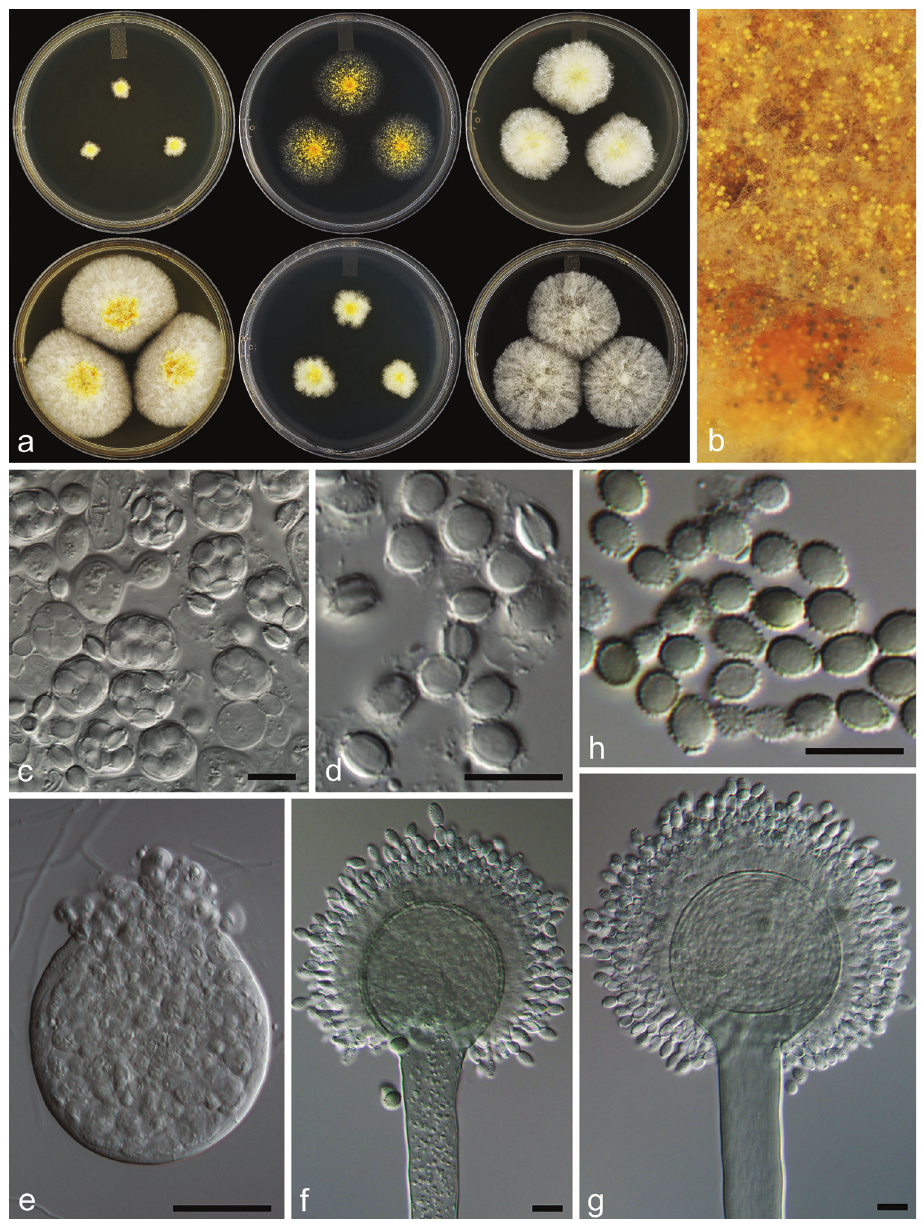
Figure 5. Aspergillus mallochii (DAOMC 146054). a Colonies on MEA, MEA20S, MY10-12 (top row, from left to right), DG18, CY20S, MY50G (bottom row, from left to right) b Texture on DG18 c Asci d Ascospores e Cleistothecium f, g Conidiophores h Conidia. Scale bars: e = 50 µm, c, d, f–h = 10